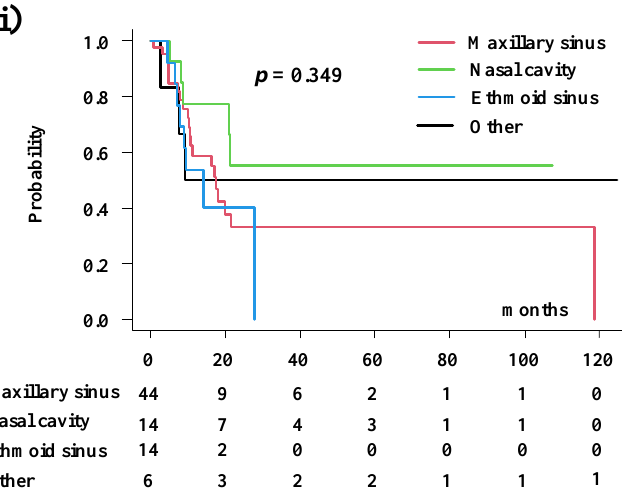
Figure 1. Local control and overall survival rate after reirradiation for nasal cavity or paranasal sinus tumor. ( a ) Total population. Local control (LC) and survival rate (OS). ( b ) Local control rate according to prescribed dose. ( c ) Overall survival according to gender. ( d ) Overall survival according to histology. ( e ) Overall survival according to gross tumor volume (GTV). ( f ) Overall survival according to interval between previous radiotherapy and reirradiation. ( g ) Overall survival according to lymph node involvement. ( h ) Overall survival according to prescribed dose. ( i ) Overall survival according to primary site. Table 2. Multi-variate analysis for survival rate using Cox proportional hazards